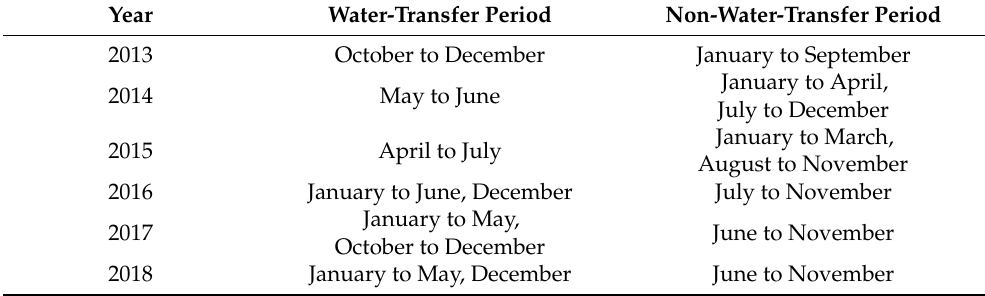
Table 1. Water-transfer and non-water-transfer months in Dongping Lake under SNWDP-ER operation.